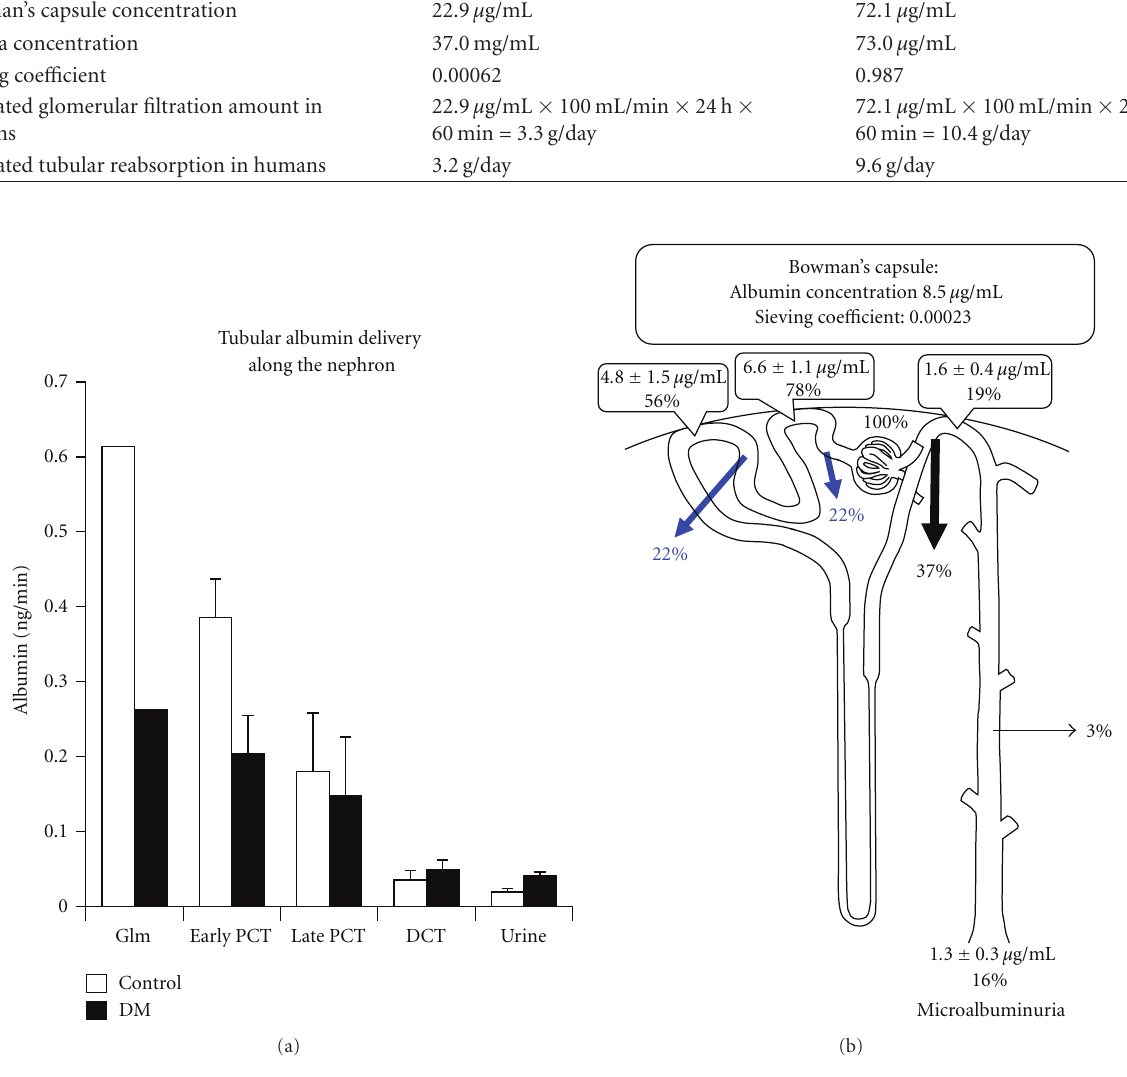
albumin-binding receptors back to the plasma